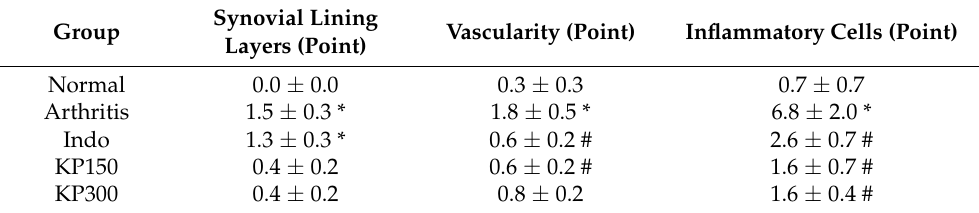
Table 1. Histological grading of synovial inflammation in the hind paw joint of the experimental rats using Gynther’s system [14].